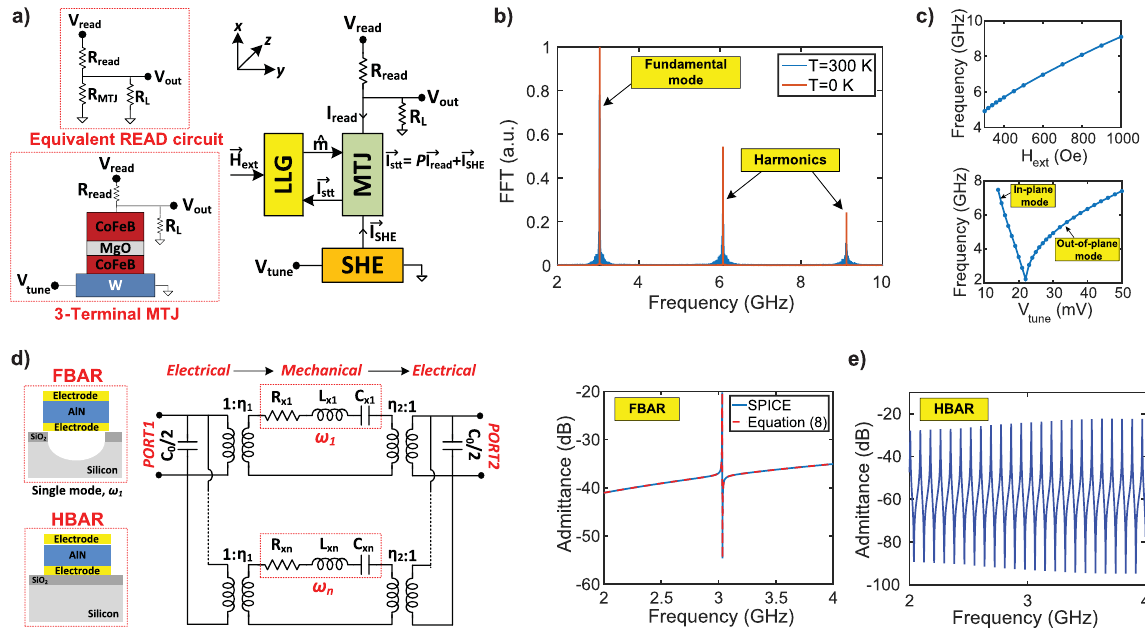
Figure 2. Decoupled STNO and HBAR module: ( a ) Modular modeling of transport and magnetization dynamics of the STNO. ( b ) Simulated FFT spectrums of a free running STNO at T = 300 K and T = 0 K (noiseless) for V tune = 23 mV, showing the fundamental mode and harmonics. ( c ) Tunability of a free running → STNO with H ext and V tune . ( d ) Equivalent circuit model for the HBAR where each acoustic mode is modeled as a separate RLC circuit. ( e ) Admittance plots of a single mode resonator (FBAR) and a 2-port HBAR filter, consistent with the Equation (8). HBAR has multiple high Q resonance peaks that are spaced by Δ f = 43 MHz depending on the substrate